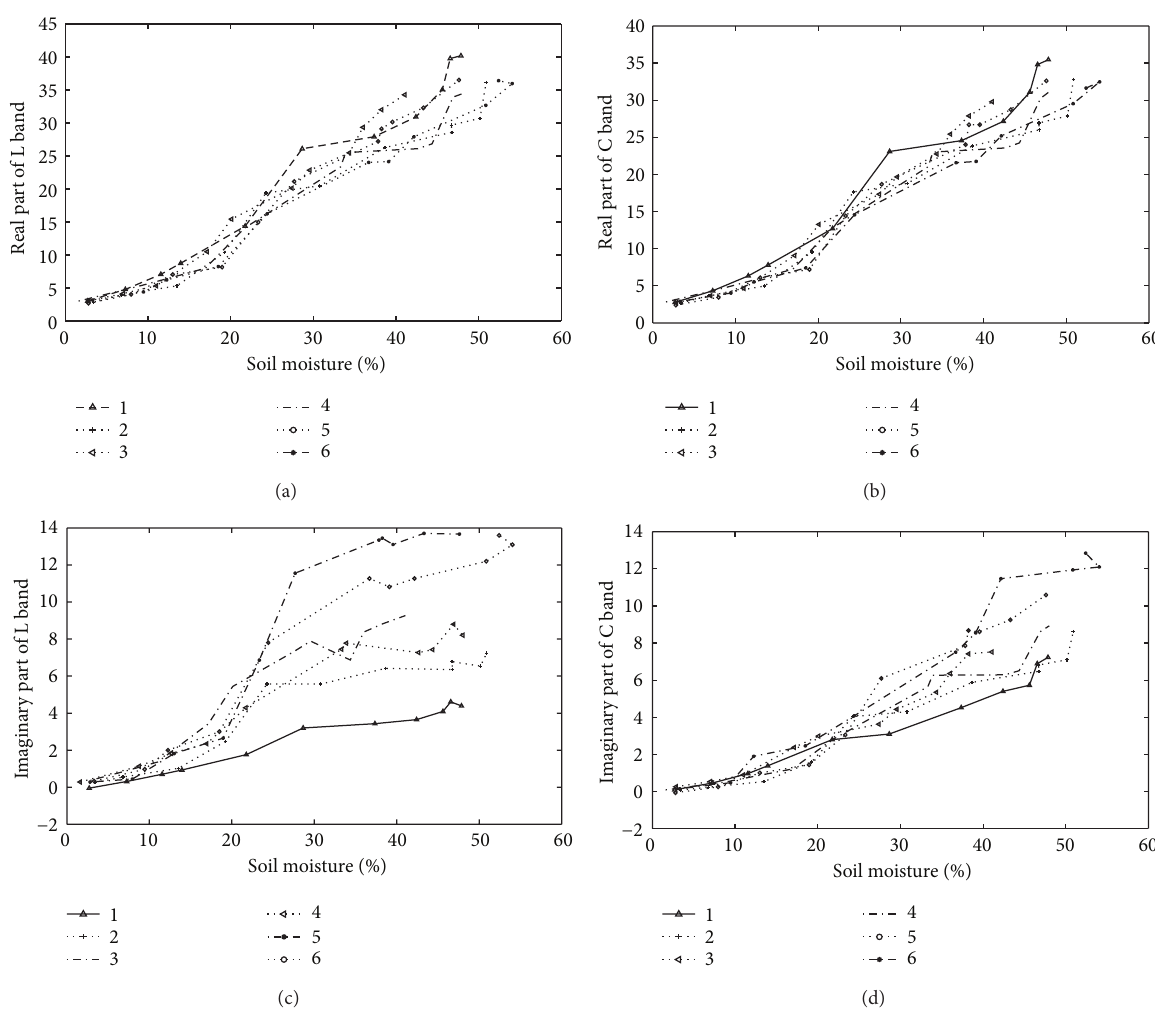
Figure 6: Measurement of the dielectric constant of the L band and C band (6 sample points are taken with different salinity contents as an